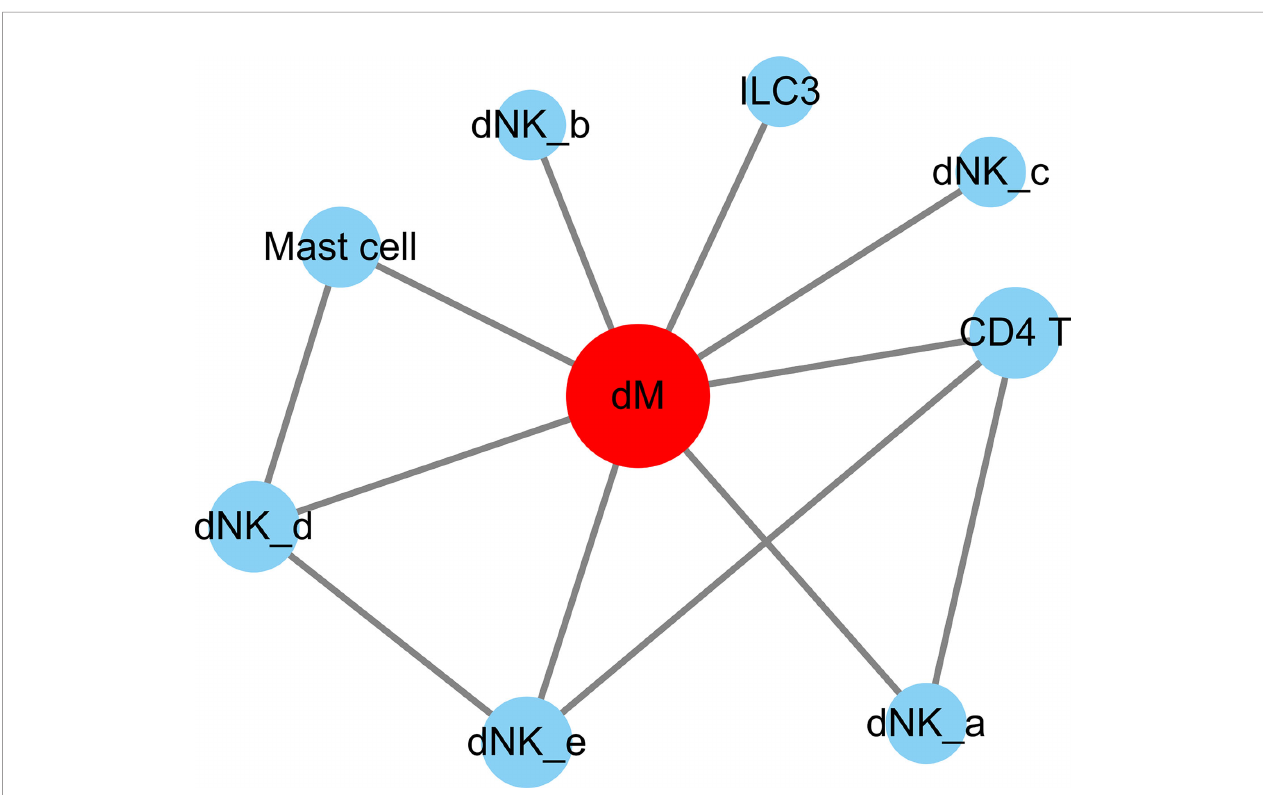
FIGURE 5 | The cell-to-cell interactions of DEGs involved. The nodes are cell types and the segments are cell-to-cell interactions. The red node indicates cell types that are highly interacted with other cells. The size of the different cell types is proportional to the amount of total number of interactions with the red node. dM, decidual macrophages; dNK, decidual natural killer cells; ILC, innate lymphoid